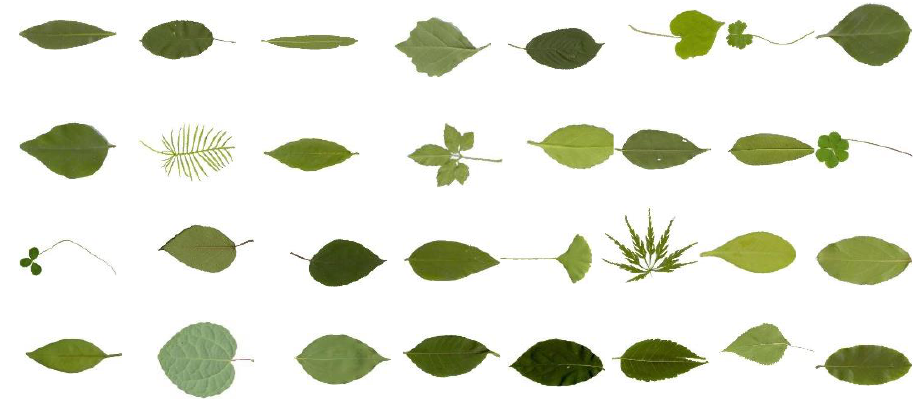
Figure 8. Standard leaf image of ICL dataset.